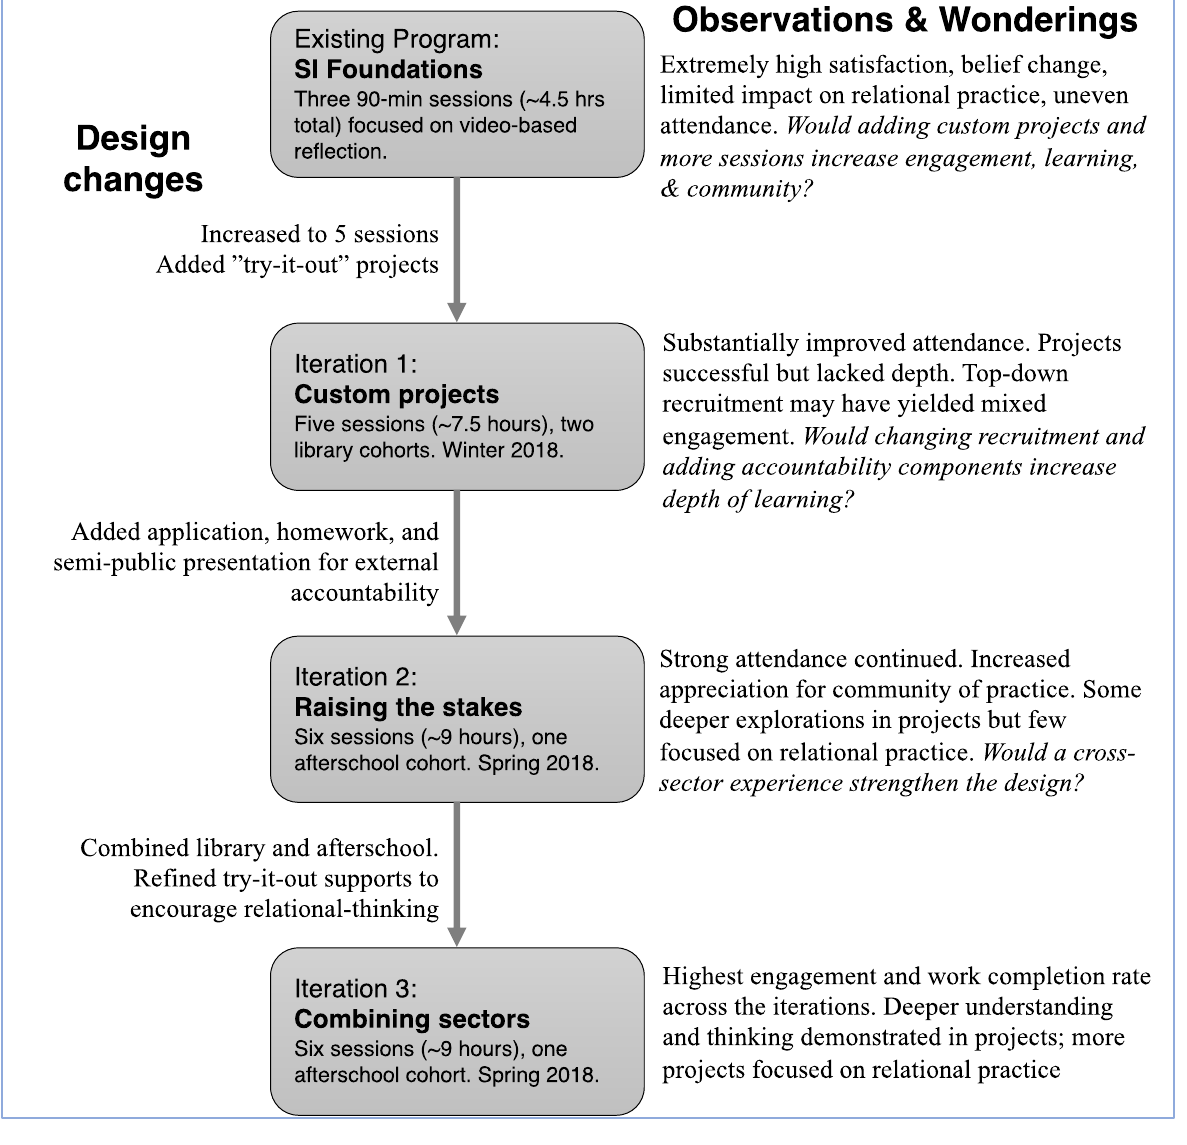
Figure 1. Evolution of Design Across Three